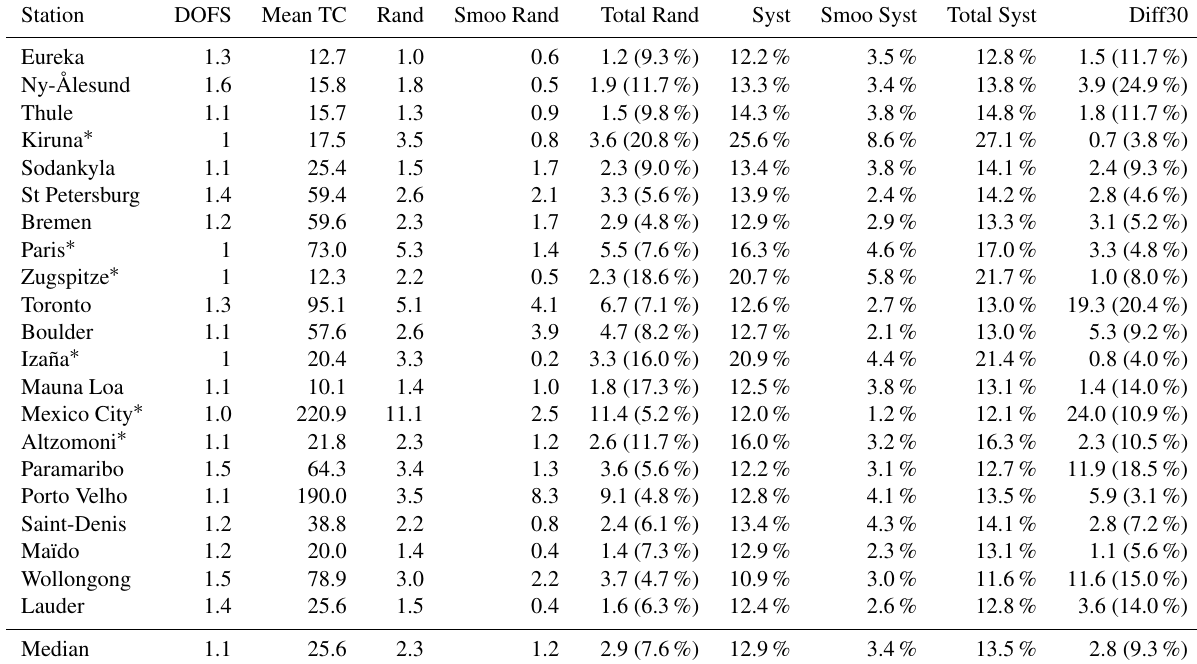
Table 3. Mean of the HCHO total columns (TC) in 10 14 moleccm − 2 and degrees of freedom for signal (DOFS) obtained at each FTIR station. The stations with strictly 1 DOFS (Kiruna, Izaña, Zugspitze, and Paris) only make a scaling of the HCHO a priori profile; i.e. no change in the vertical shape of the a priori profile is allowed. We give, in 10 14 moleccm − 2 , the mean of (1) the random uncertainties (Rand) that were calculated for each individual HCHO total column (excluding the smoothing part); (2) the smoothing random error (Smoo Rand); p (3) the total random error (Total Rand = Rand 2 + Smoo Rand 2 ). We also provide the total random error in % for completeness. We give the mean of the systematic uncertainties in %: first without the smoothing part (Syst), then the smoothing systematic error (Smoo Syst), and q the total systematic error (Total Syst = Syst 2 + Smoo Syst 2 ). If the Rodgers and Connor (2003) methodology is used in model–instrument comparisons, only the Rand and Syst uncertainties need to be taken into account (not the total errors). In addition, we provide the mean differences between two subsequent FTIR measurements taken within 30min (Diff30) in both absolute (10 14 moleccm − 2 ) and percent units relative to mean TC. The PROFFIT stations are indicated with ( ∗